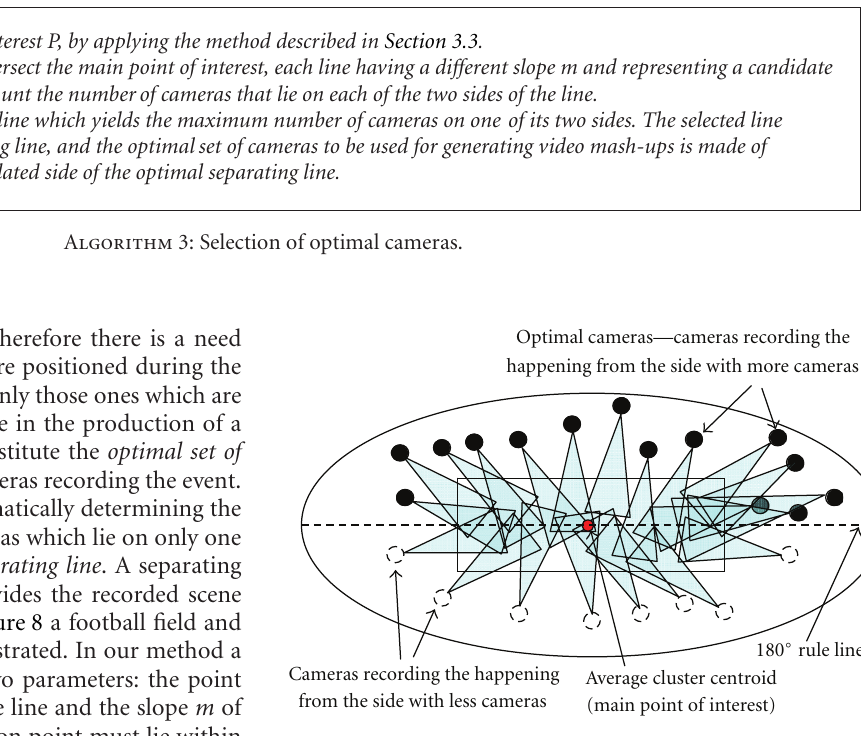
Figure 8: Identification of the 180-degree rule line (the separating line ) and selection of optimal cameras (view from the top).